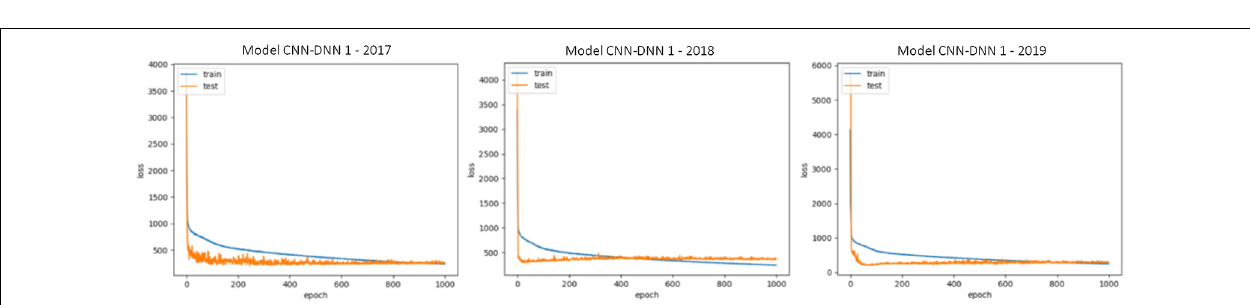
FIGURE 4 | Comparing prediction error (relative RMSE) of the homogeneous model with the benchmark on the data from the year 2019 taken as the test data.